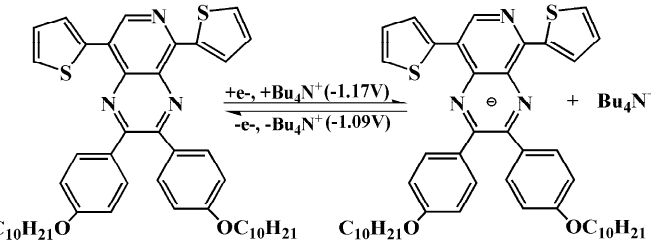
Figure 2. CV curves of the polymers for p-doping and n-doping processes at various scan rates: ( a ) P1; ( b ) P2; ( c ) P3; and ( d ) P4.